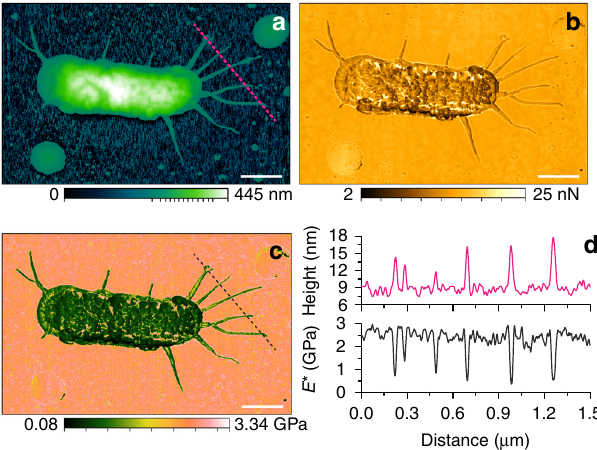
Fig. 7 High spatial resolution NM of an E . coli TOP10 cell. a Topography. Maps of b , the adhesion force and c , the reduced elastic modulus calculated from DMT theory. d Pro fi les of the height (top) and reduced elastic modulus (bottom) obtained from a – c , respectively. Scale bar, 500